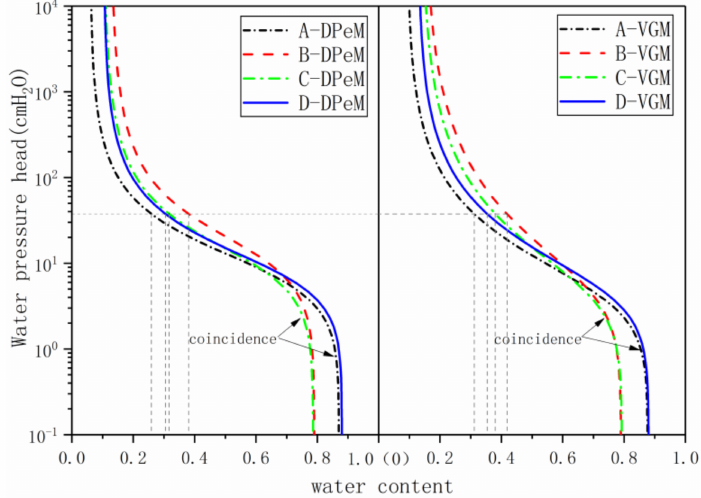
Figure 5. Characteristics of soil water in different physical